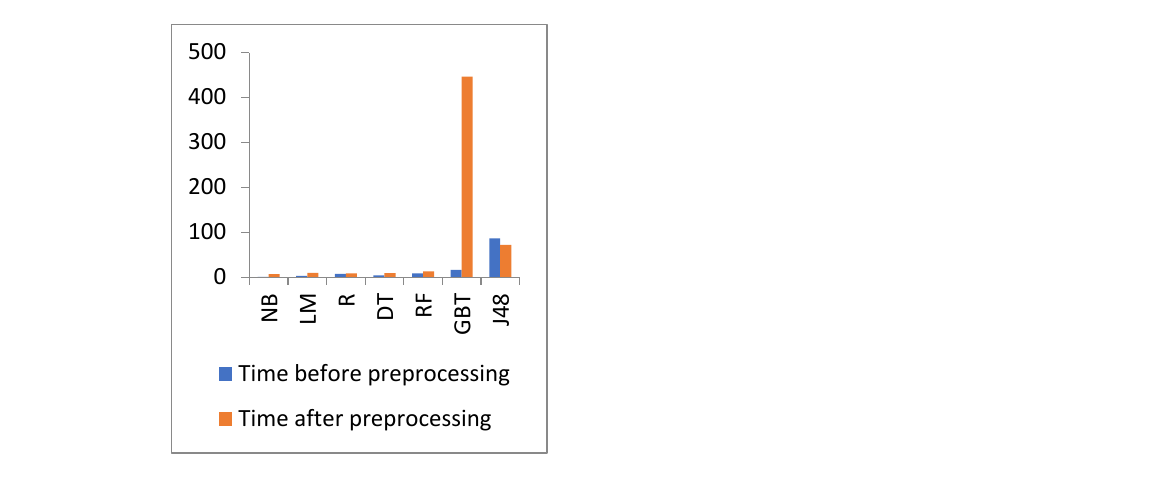
Figure 11. Time comparison of different algorithms on general health before and after preprocessing.